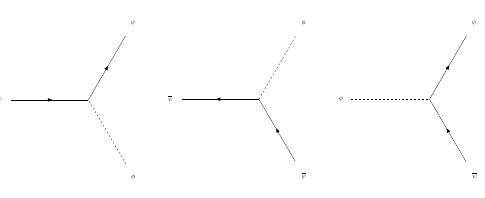
Figure 2: ψ Bremsstrahlung, ψ Bremsstrahlung and ψψ pair